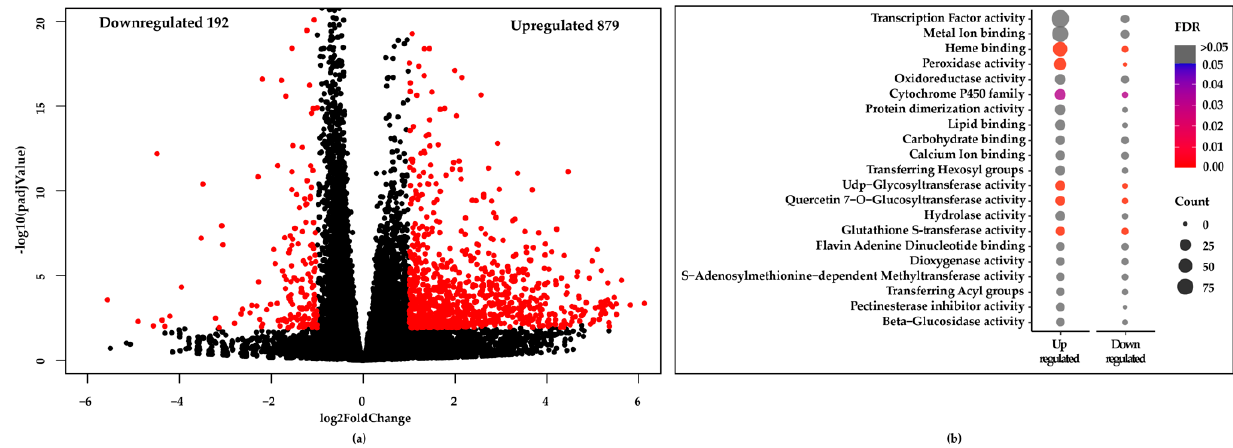
Figure 5. Differentially expressed genes and their corresponding molecular functions. ( a ) Volcano plot of significantly up and downregulated genes. X-axis and y-axis denote the log 2 FoldChange and -log10 of padj values, respectively; where log 2 FoldChange ≥ 1.0 and padj < 0.05 were considered as significant and indicated in red color. ( b ) Gene enrichment analysis of the significant genes. Color and bubble indicate the false discovery rate (FDR) and number of genes belong to each class, respectively. Table 1. List of genes involved in H 2 O 2 detoxification or signaling were more upregulated in Cu-chl NaCl compared to NaCl. AtPrx, arabidopsis thaliana Class III peroxidase; Trx, thioredoxin superfamily protein; Rboh, respiratory burst oxi- dase homolog/riboflavin synthase-like superfamily protein; Dox, alpha dioxygenase Tpx, thioredoxin-dependent peroxi- dase; GSTU, glutathione S-transferase class tau; GSTL, glutathione S-transferase lambda; GSTF, glutathione S-transferase class phi.